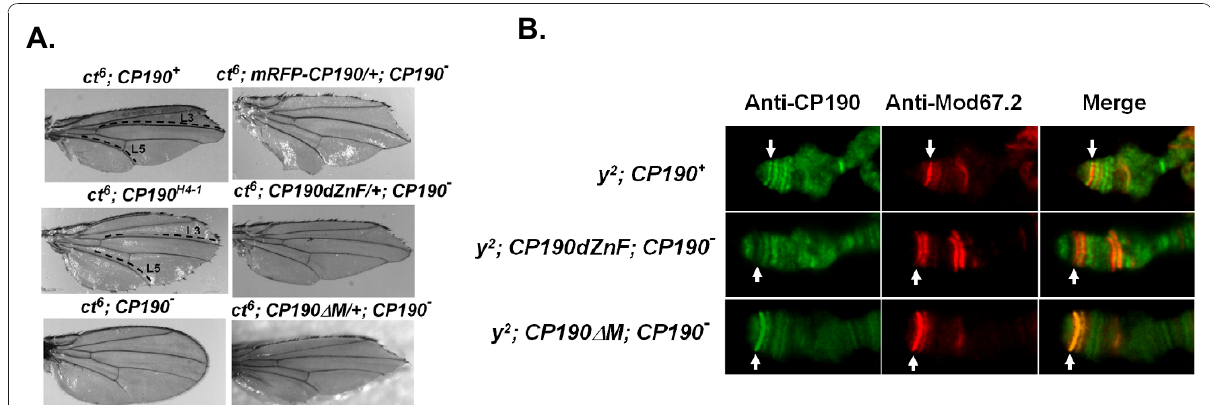
Figure 2 The GFP-CP190dZnF and the Cp190 Δ M proteins are fully functional in the gypsy insulator . (A) The gypsy insulator-dependent wing phenotype of the ct 6 mutation in the indicated genetic backgrounds. Wings of the ct 6 flies have a cut shape and lack of margin bristles (top left). The two doted lines mark the veins L3 and L5 between which the margin bristles are not developed at all. The ct 6 ; CP190 H4-1 wing has some margin bristles between L3 and L5, and is rounder in shape (middle left). The wing shape of the CP190 deficient CP190 3 /CP190 P1 flies is restored to a ct + -like shape with fully developed margin bristles (bottom left), indicated. A copy of the P[Ubi63e::mRFP-CP190] (top right), P [Ubi63e::GFP-CP190dZnF] (middle right) or the P[CP190 Δ M] (bottom right) transgene rescues the defective gypsy insulator function in the CP190 deficient CP190 3 /CP190 P1 background. The rescued flies have the cut wing shape similar to the ct 6 ; CP190 + flies. (B) Localization of the mutated Cp190 proteins to the gypsy insulator insertion at the y locus on the y 2 polytene chromosome. Shown are the tips of X chromosomes. The y locus that contains a copy of the gypsy insulator is indicated by white arrows. Distribution of the GFP-CP190dZnF protein (middle panel) and the Cp190 Δ M protein (bottom panel) on the polytene chromosomes of the indicated flies was revealed by anti-Cp190 (left column). The anti-Mod (mdg4)67.2 (middle column) shows the distribution of the Su(Hw) insulator complex. The right column shows the merged images of the left and the middle